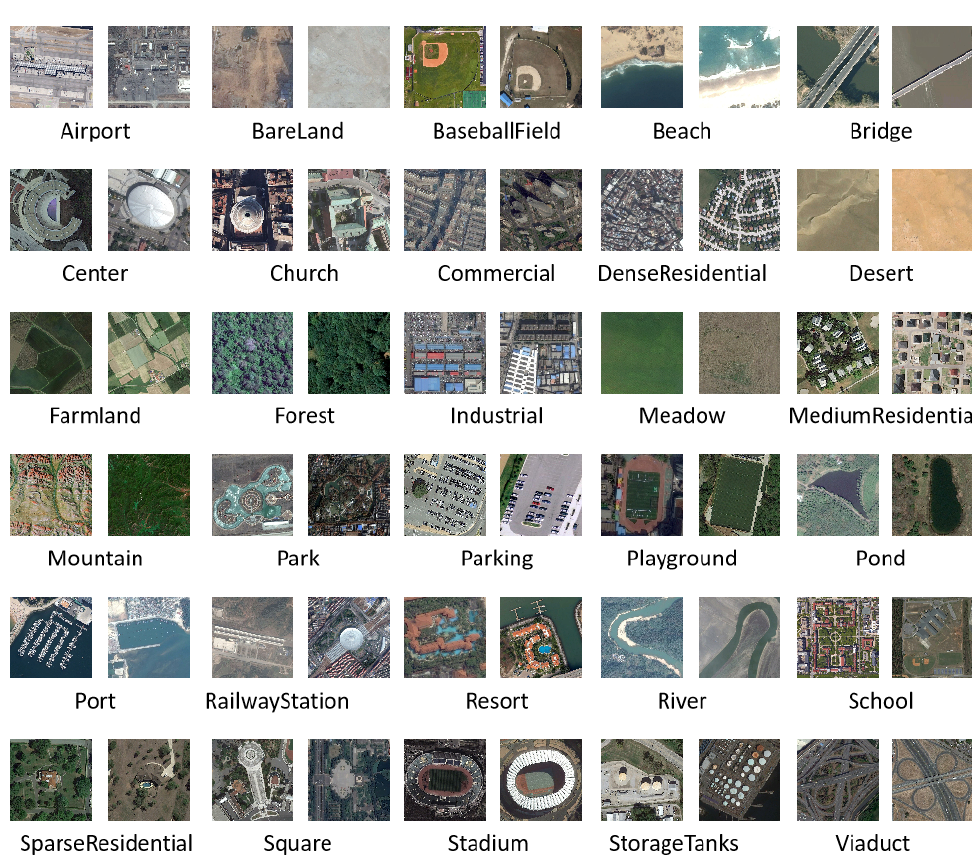
Figure 2. Some remote sensing sample images in UCM21, AID30, and NWPU45